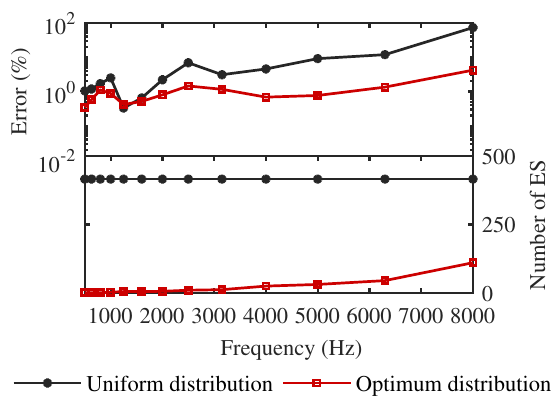
Figure 14. The relative error of the sound pressure ( top ) and the number of equivalent sources ( bottom ) versus